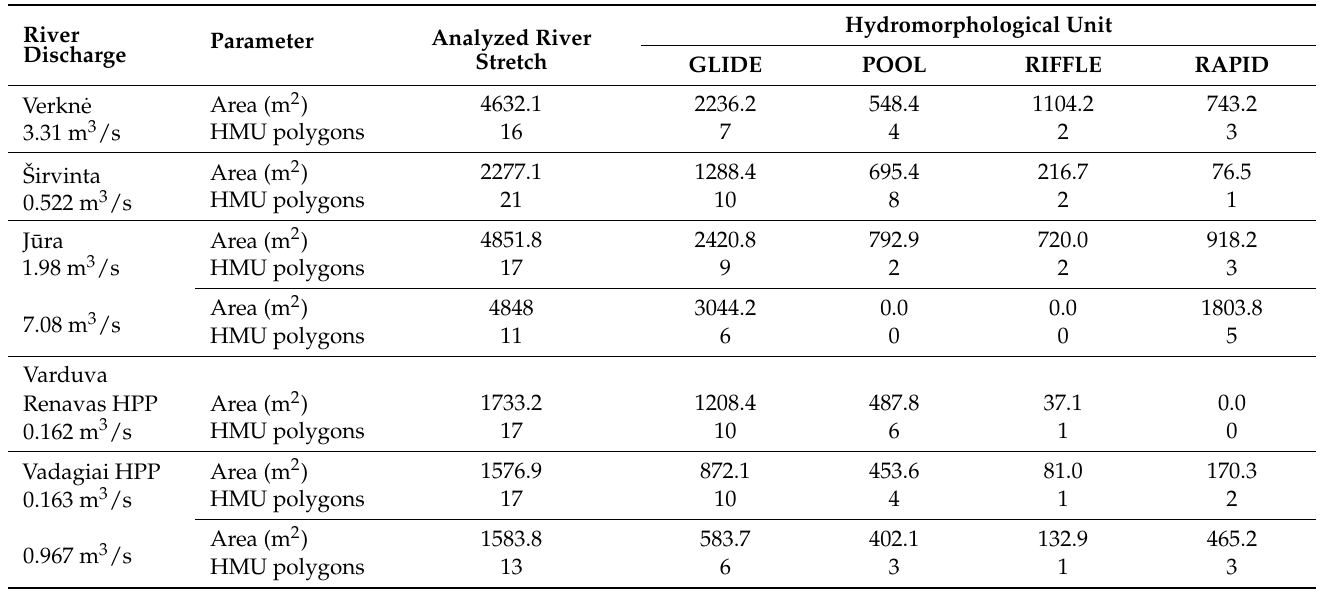
Table A1. Area and numbers of HMU polygons at the analyzed river